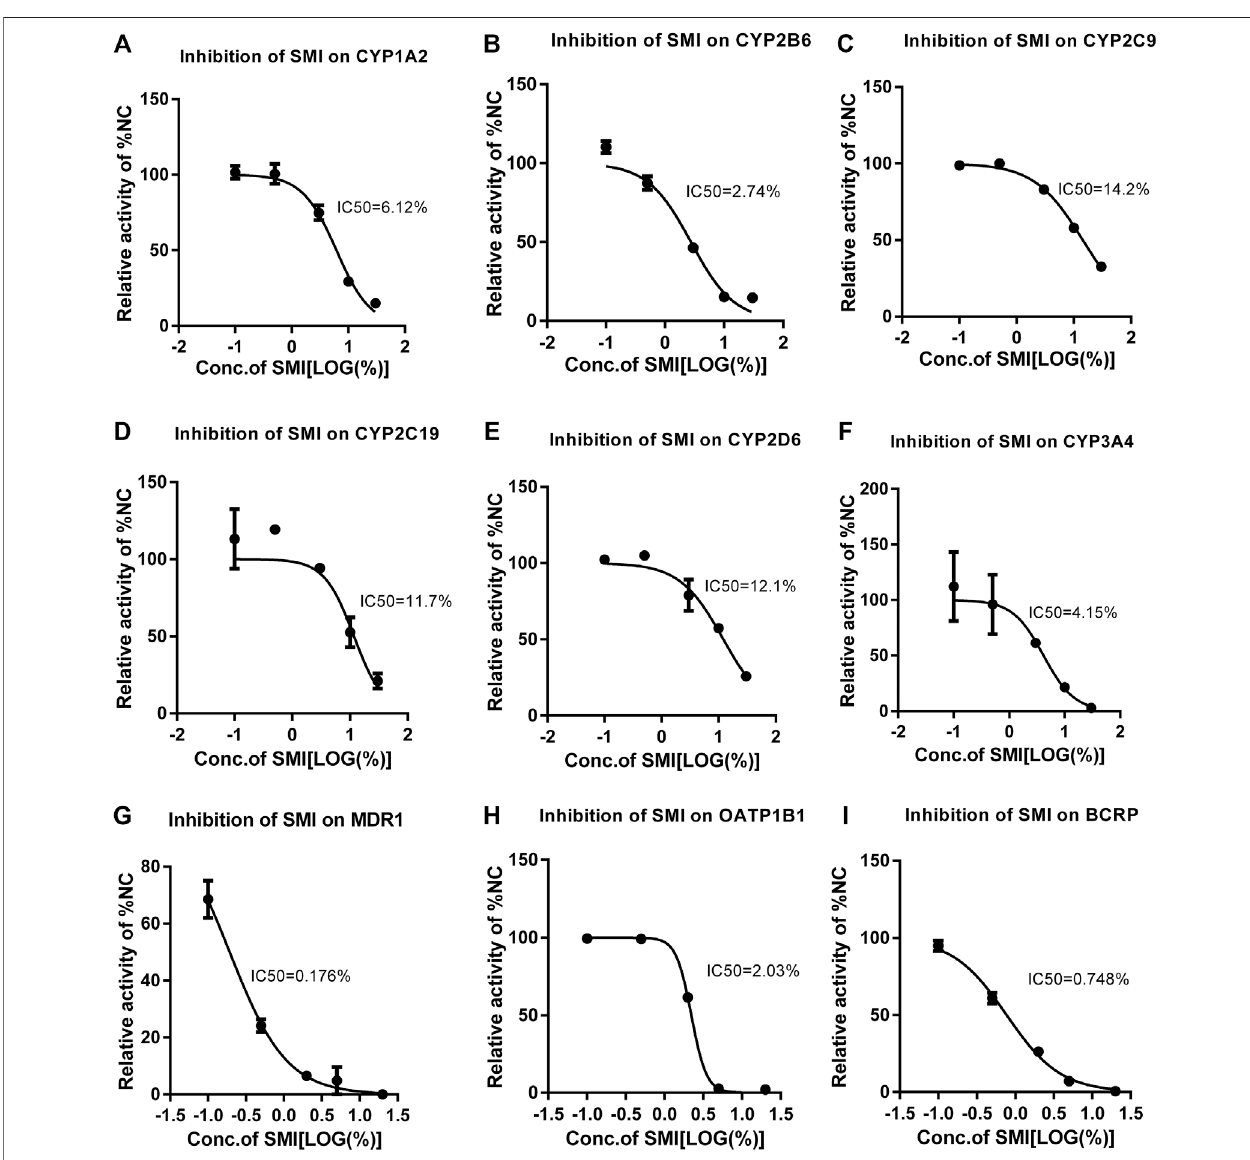
FIGURE 5 | Different concentrations of SMI correspond to different CYP450 enzyme activities and the IC50 curve. X is the logarithm of SMI concentration; Y is the corresponding percentage of NC. The nonlinear formula, “ Y = 100/(1 + 10 ^ ((X-logic50))" (Y starts at Bottom and goes to Top with a sigmoid shape). The results showed that SMI had different inhibitory effects on CYP1A2 (A) , 2B6 (B) , 2C9 (C) , 2C19 (D) , 2D6 (E) , 3A4 (F) , MDR1 (G) , BCRP (H) , OATP1B1 (I) . As for CYP2C8, since SMI increased CYP2C8 metabolism in the no/weak inhibition interval, inhibition was only observed at high concentrations. When it is not clear why SMI increases CYP2C8metabolismintheno/weakinhibitioninterval,thecurrenttestsystemcannotdetermineamoreaccurateIC50.Therefore,thedatacannot fi ttheIC50curve.We can only be sure that the IC50 value is between 10 and 30%.